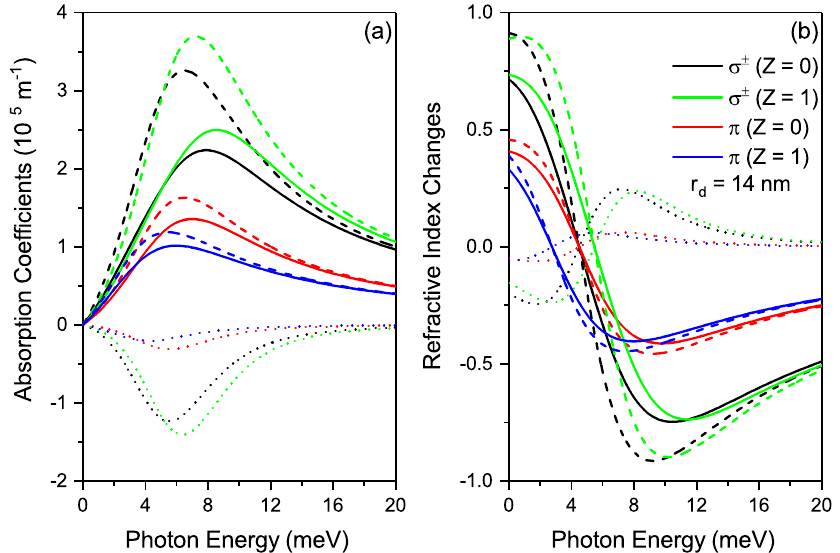
Figure 3. ( a ) The plot of optical absorption coefficient as a function of the photon energy. ( b ) The Refractive index changes as a function of the photon energy. Both plots are for σ ± ( Z = 0 ) , σ ± ( Z = 1 ) , π ( Z = 0 ) and π ( Z = 1 ) transitions. In ( a , b ), the dashed, doted and solid curves are for linear, third-order nonlinear and total optical absorption coefficients (Refractive Index Changes)